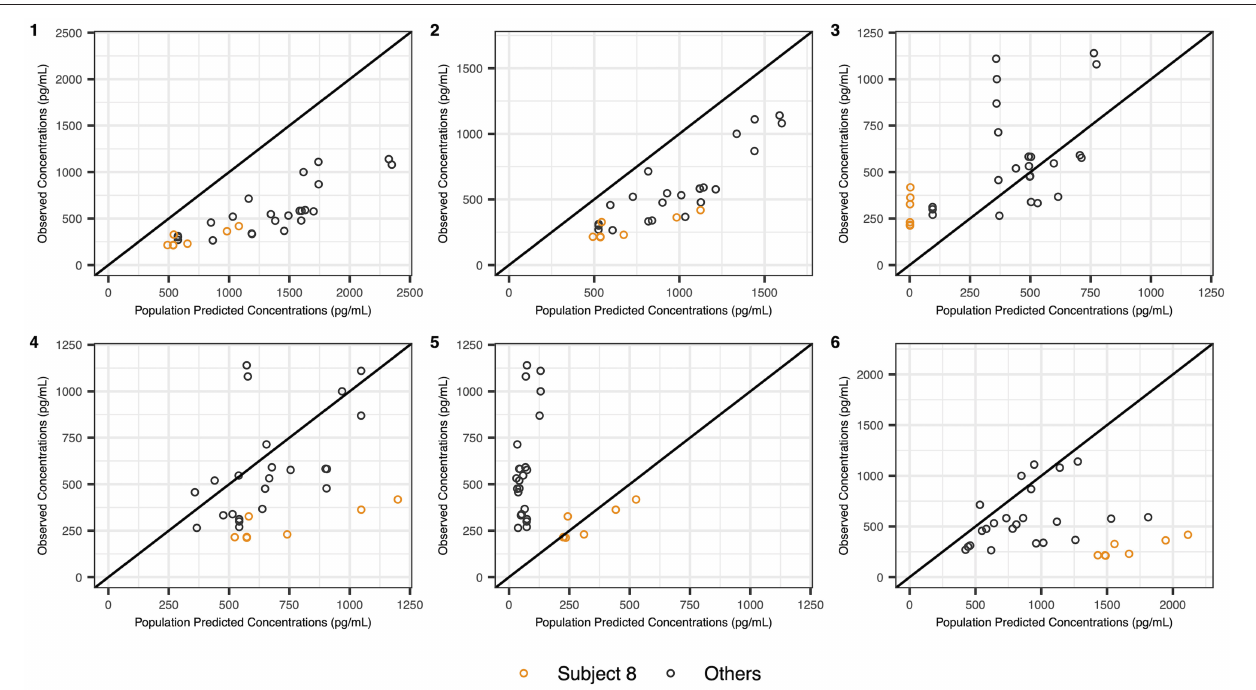
FIGURE 2 | Observed concentrations vs. population predicted concentrations using previously published pharmacokinetics models in children. Observed concentrations vs. population predicted concentrations using population pharmacokinetics models developed by (1) Potts et al. (12), (2) van Dijkman et al. (13), (3) Greenberg et al. (14), (4) Su et al. (15), (5) Damian et al. (16), and (6) James et al.